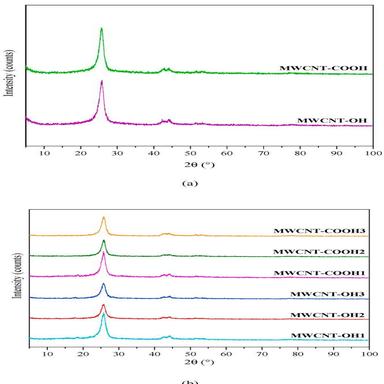
XRD patterns of MWCNTs before (a) and after (b) green synthesis. (For interpretation of the references to color in this figure legend, the reader is referred to the Web version of this article.)